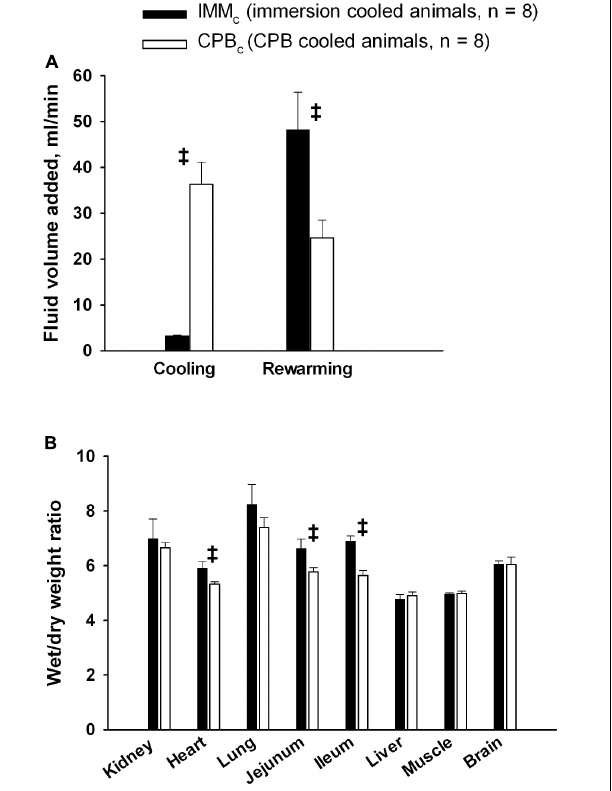
FIGURE 8 | Fluid administration and organ edema. (A) : Fluid volume administration rate. (B) : Postmortem wet/dry organ weight ratio. Data presented as mean and SEM. ‡ Statistically significant difference between groups ( p <